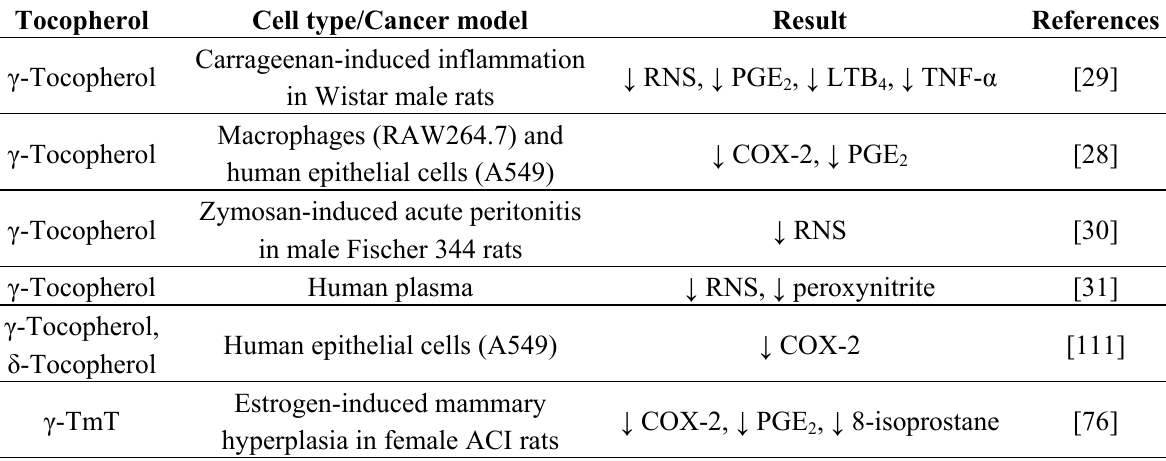
Table 4. Tocopherols decrease COX-2 and